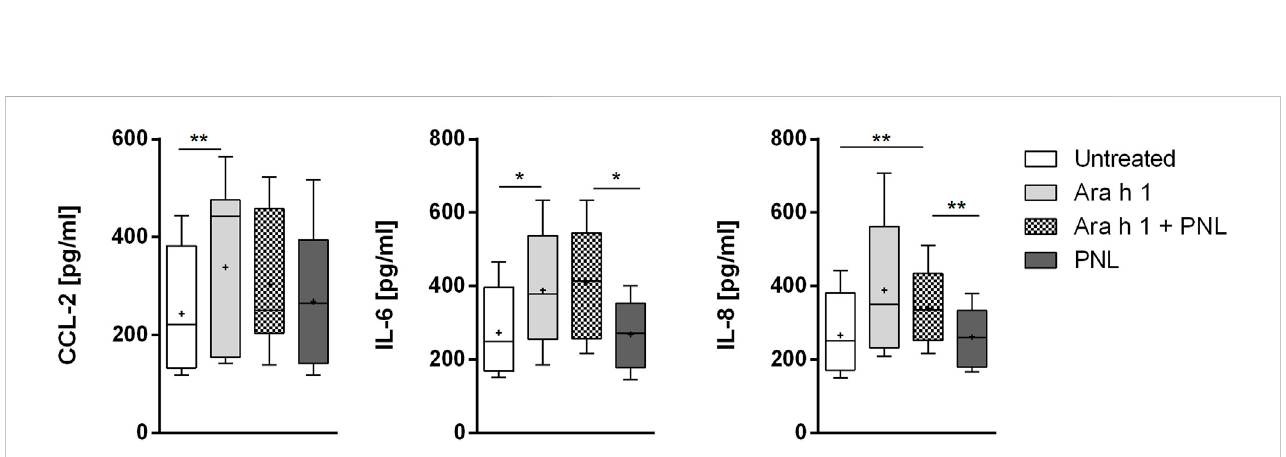
FIGURE 4 Inductionofcytokinesrelease.CellmonolayersweretreatedapicallywithArah1±PNL,andtheconcentrationsofCCL2,IL-6,andIL-8releasedintothe basolateral medium were measured after 16